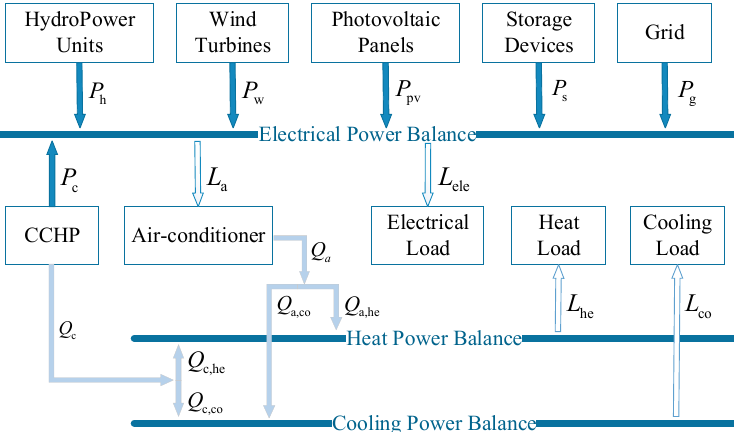
Figure 1. Block diagram of multi-energy virtual power plant (ME-VPP).